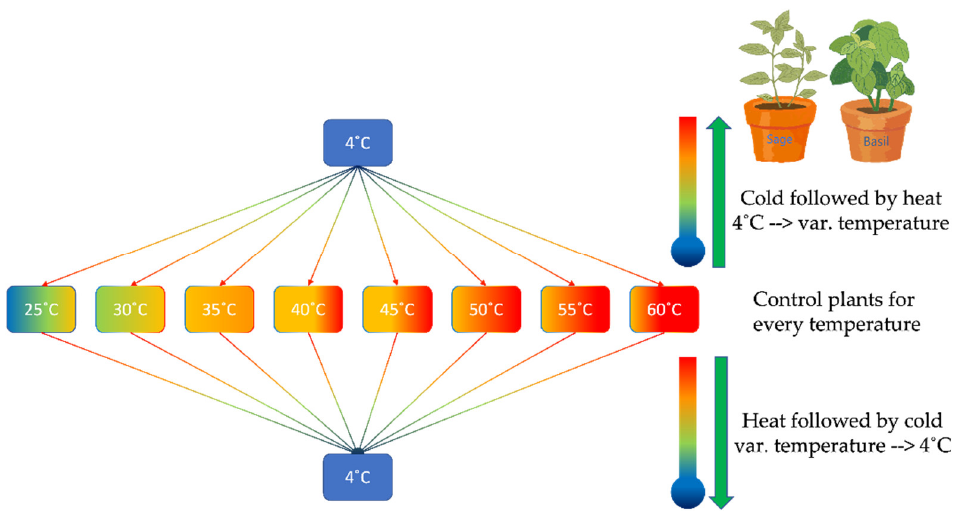
Figure 10. Experimental